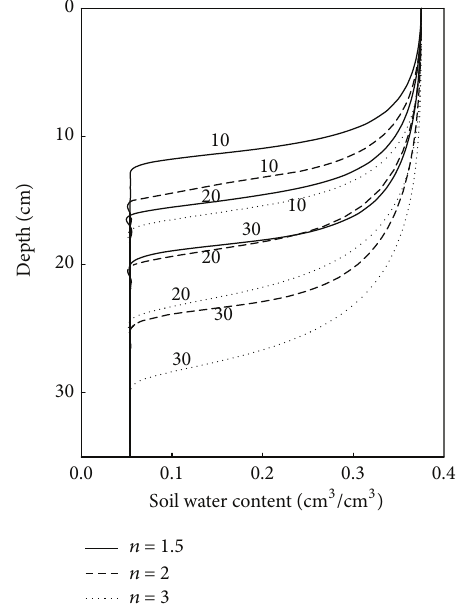
Figure 7: Simulated soil water content profiles after different infiltration times (10, 20, and 30 min) for different values of the 𝑛 parameter in the